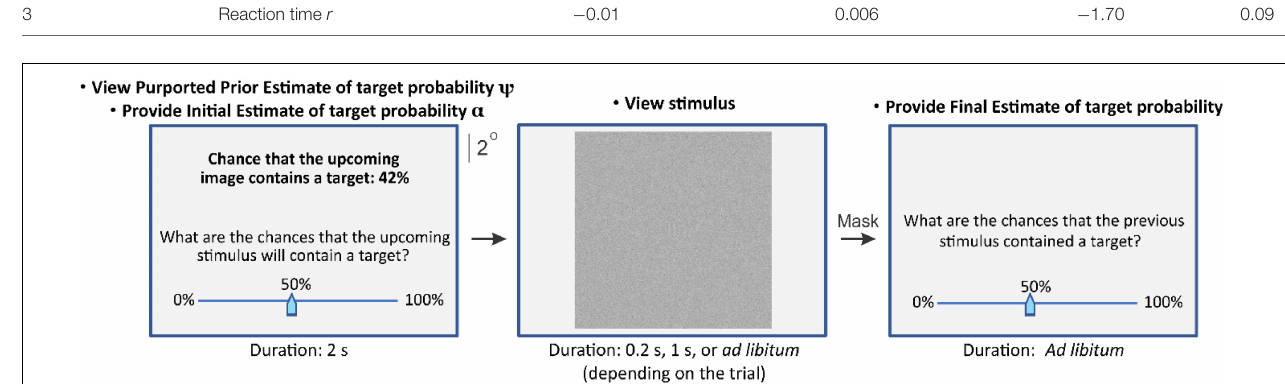
FIGURE 4 | Task paradigm of Experiment 3. In this experiment, the visual stimulus was a dynamic random dot stimulus (dRDS), one static frame of which is shown in this figure ( middle panel ). In 50% of the randomly interleaved trials, the dRDS contained in Gabor patch at the subject’s contrast threshold (Kersten, 1984). See text for details.